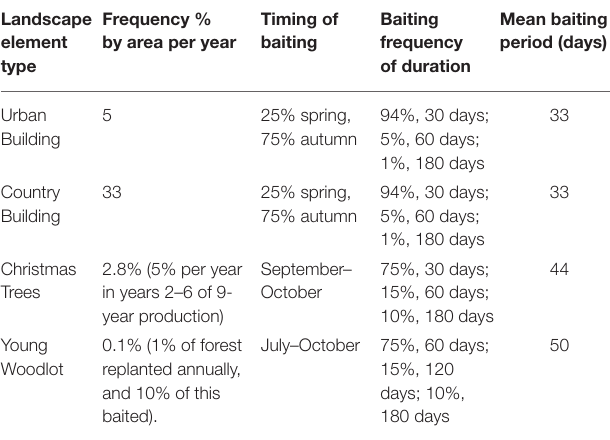
TABLE 2 | The default frequency, timings of start of baiting and baiting duration used for the all scenarios unless otherwise specified. Landscape